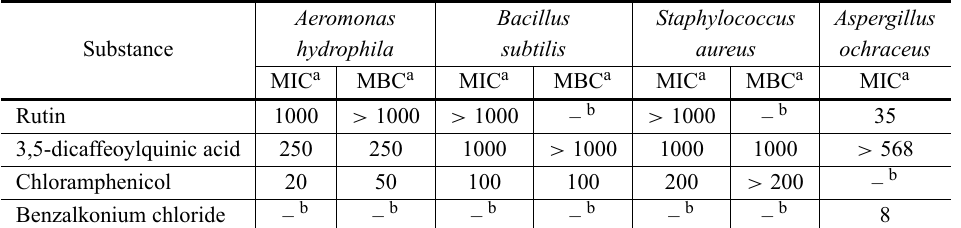
Minimal inhibitory concentration (MIC) and minimal bactericidal concentration (MBC) of rutin and 3,5-dicaffeoylquinic acid. Aeromonas Bacillus Staphylococcus Aspergillus Substance hydrophila subtilis aureus ochraceus MIC a MBC a MIC a MBC a MIC a MBC a MIC a Rutin 1000 > 1000 > 1000 – b > 1000 – b 35 3,5-dicaffeoylquinic acid 250 250 1000 > 1000 1000 1000 > 568 Chloramphenicol 20 50 100 100 200 > 200 – b Benzalkonium chloride – b – b – b – b – b – b 8 a Values in μ g/mL. b not